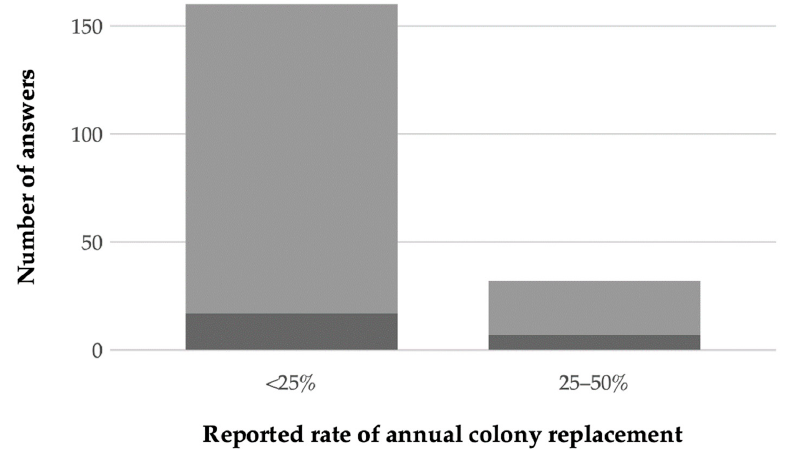
7 of 12 is shown (dark gray = surviving populations with >30 colonies, N = 29; light gray = groups between five and 30 colonies, N = 195). Respondents reporting of managed surviving colonies also indicated the proportion of colonies that needed to be replaced annually in order to maintain the stock (Figure 4). Among these, the majority (N = 160, 80%) reported replacing less than one-quarter of the colonies per year (Figure 4), while the remaining respondents reported replacing between one-quarter and one-half of the colonies in their stock (N = 32, 16%, Figure 4) per year. Another eight (4%) reports indicated an annual replacement rate of more than one-half.